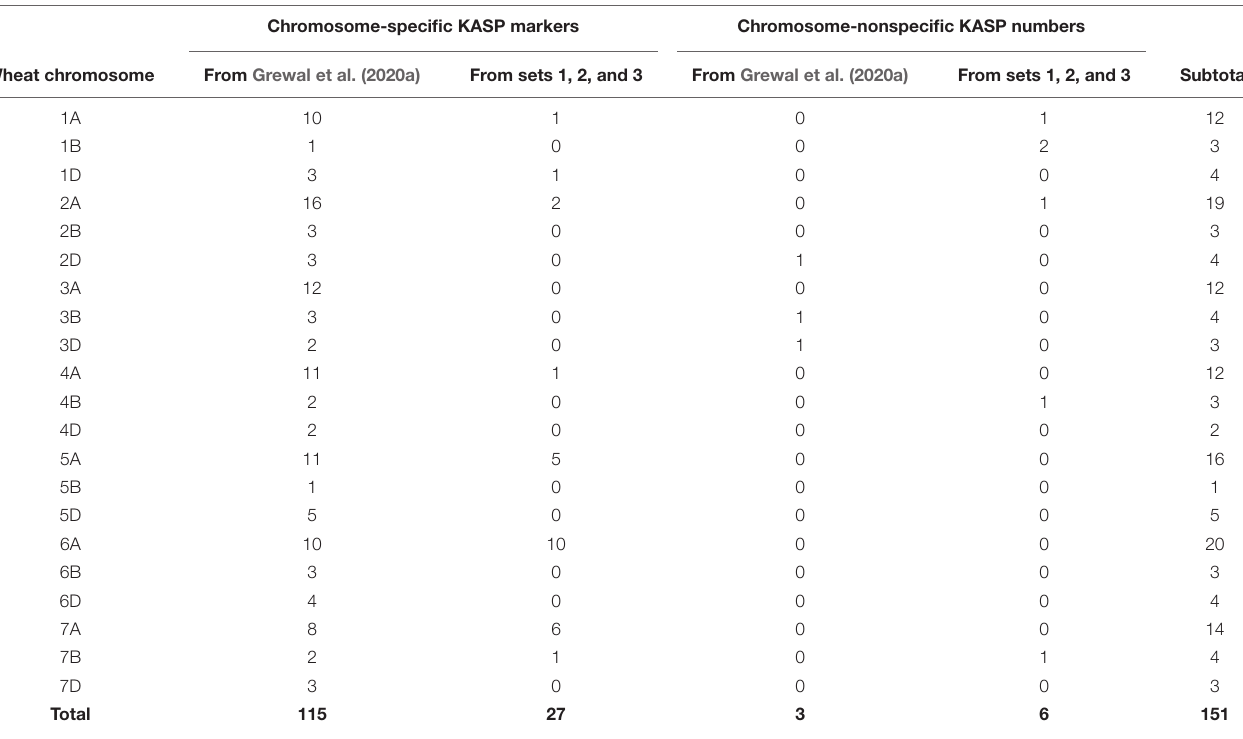
TABLE 3 | Number of chromosome-specific and nonspecific KASP markers developed for each wheat chromosome in the current study (from sets 1, 2, and 3) versus previously developed KASP markers. Chromosome-specific KASP